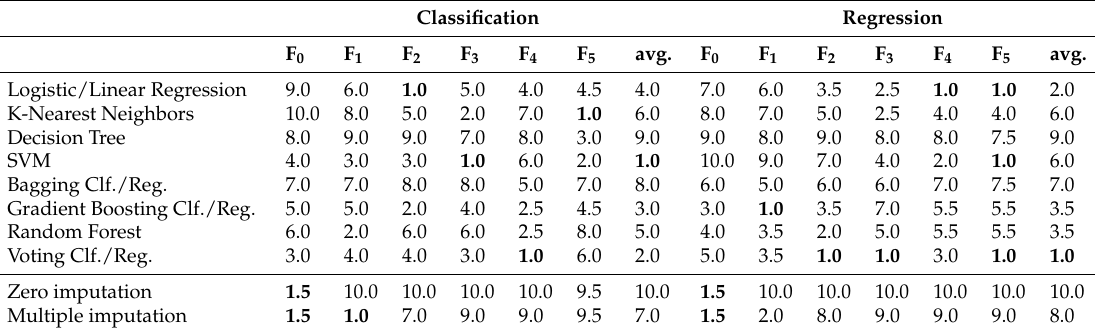
Table 4. Rankings of classification and regression models for different feature sets for fat.